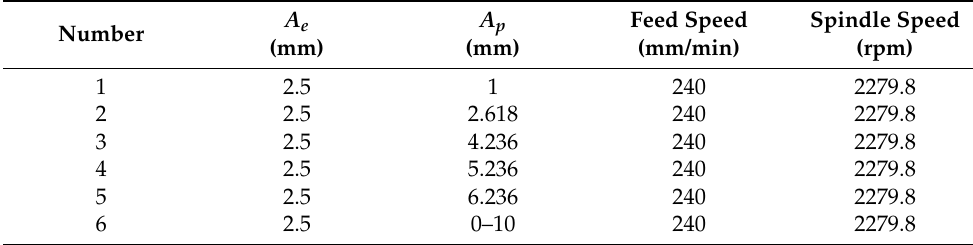
Table 2. Milling scheme of the experiment.